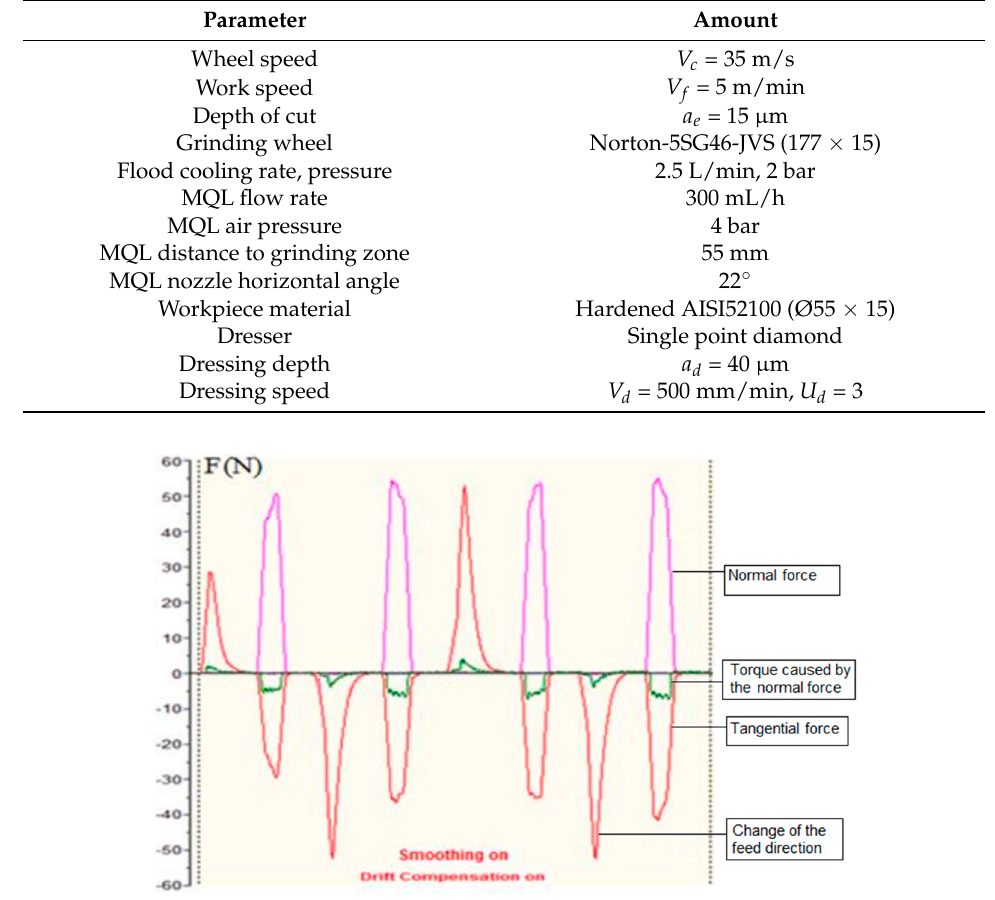
Table 2. Machining parameters.